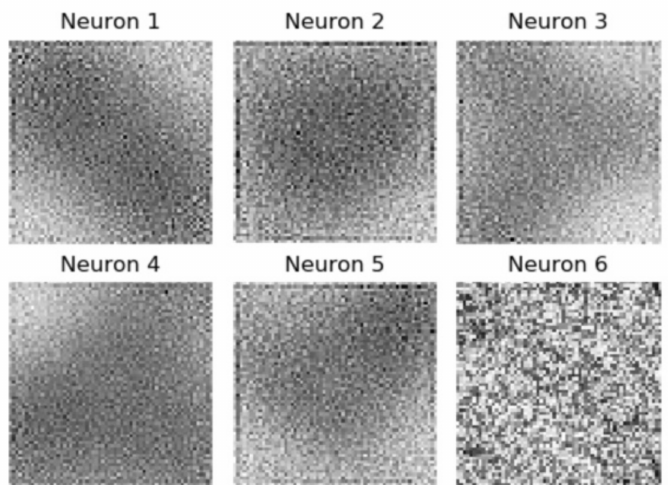
Figure 8. The weights of trained Autoencoder_6 neurons. Bright values indicate high numeric values, while dim values indicate a low numeric